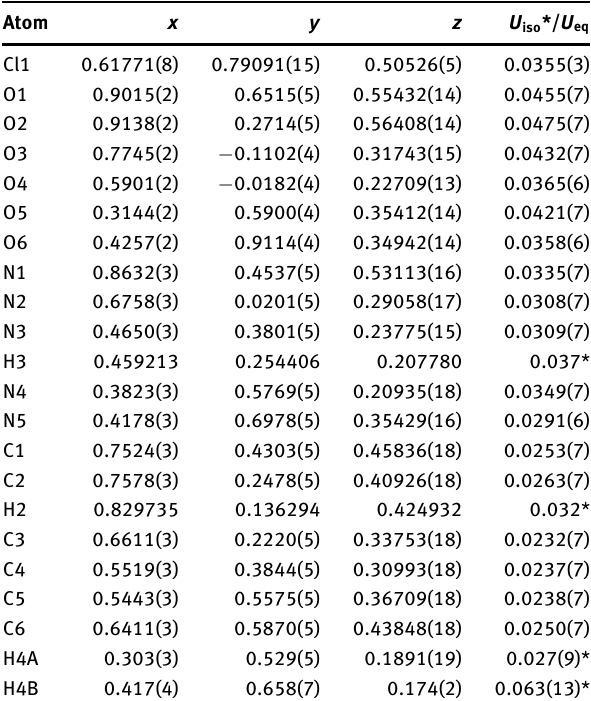
Table 2: Fractional atomic coordinates and isotropic or equivalent isotropic displacement parameters (Å 2